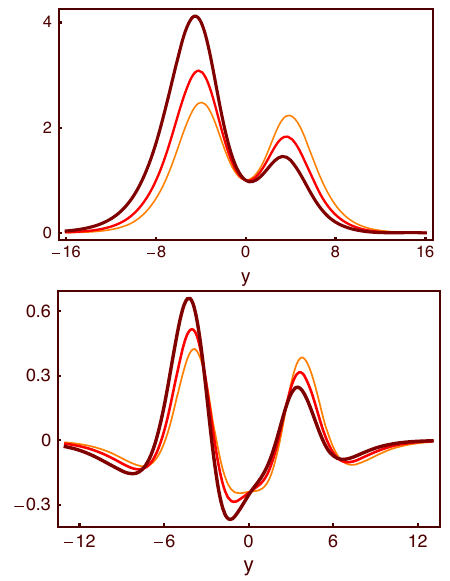
Fig. 3 From top to bottom, we depict the warp factor associated to the warp function in Eq. (21) and the energy density (11) corresponding to these solutions for r = 0 . 1 and α = 1, with c = 0 . 01 , 0 . 05 , and 0 . 1. The line thickness and color darkness increase as c increases